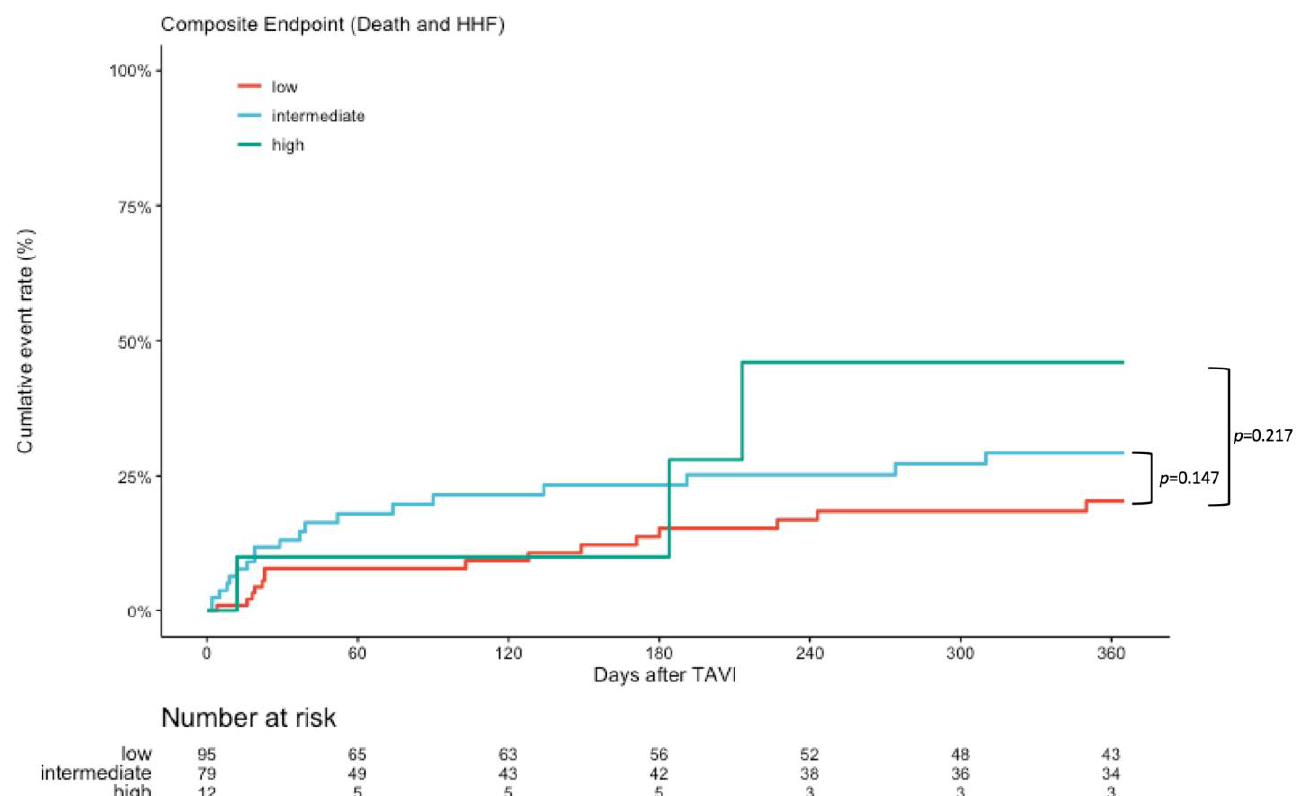
Figure 4. Kaplan–Meier survival curves for composite of HHF and mortality. Kaplan–Meier curves for composite of all-cause mortality and hospitalization for heart failure during 1-year follow-up. Values are Kaplan Estimates %. HR = Hazard Ratio. Data reported as Kaplan–Meier estimates and competitive risk estimates at the specific time point and do not equal the number of patients with events divided by the total number of patients in each treatment group. The p values for event rates were calculated using Log-Rank Test.